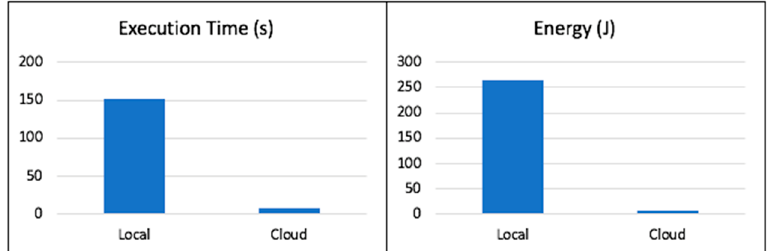
Figure 5. Running Time and Energy Consumption Comparison between Local Execution and Cloud